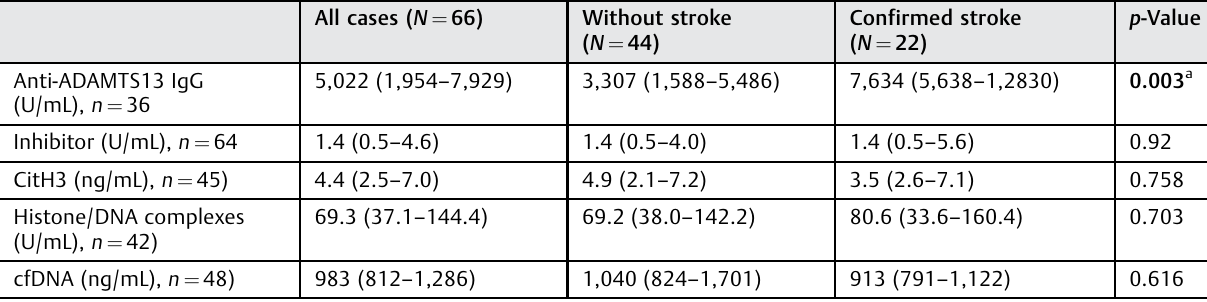
Table 3 Special laboratory parameters in iTTP patients with or without imaging-con fi rmed ischemic stroke All cases ( N ¼ 66) Without stroke ( N ¼ 44)